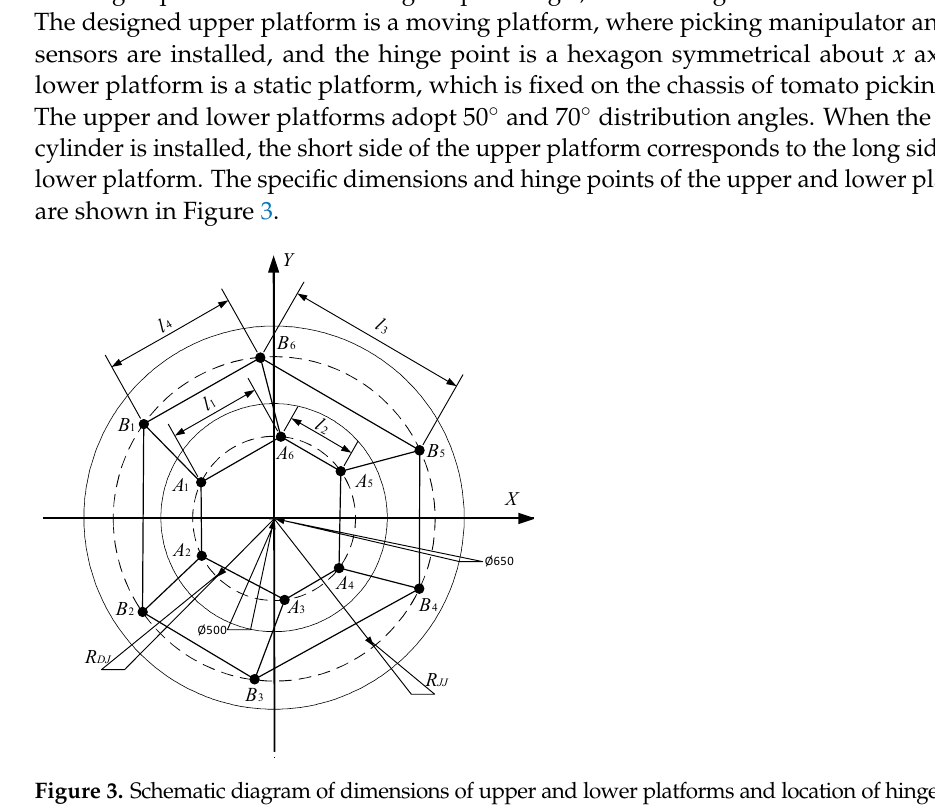
4 of 16 Figure 2. Schematic diagram of chassis structure and working range of picking robot. (1, Chassis mobile platform; 2, Lifting platform; 3, Picking mechanical arm; The red circles represent mature